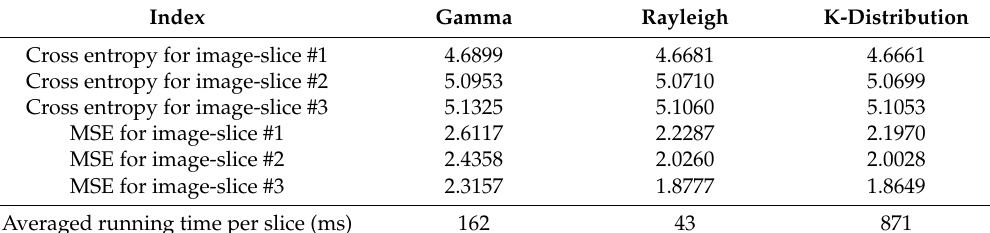
Table 2. The performance of three distributions on modeling sea clutter in GF-3 SAR imagery.